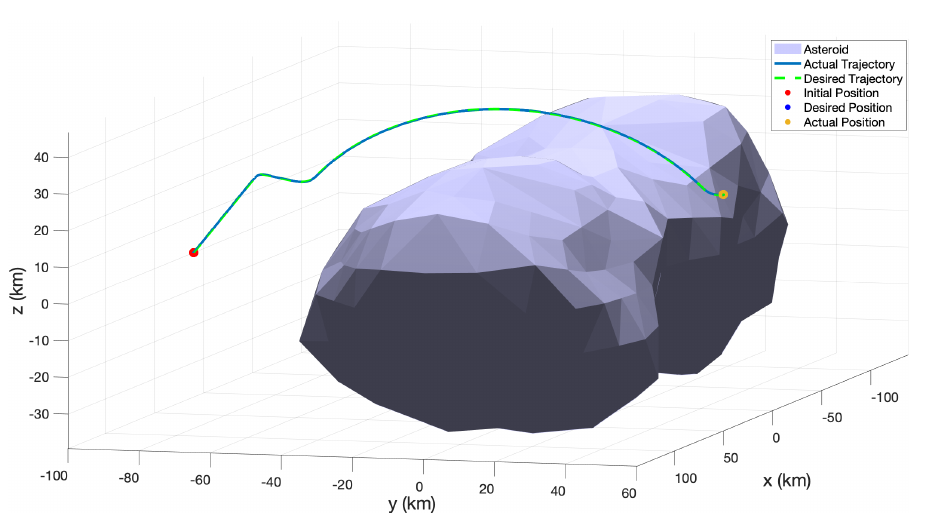
Figure 10. Trajectory of spacecraft around asteroid Kleopatra for DAMPC